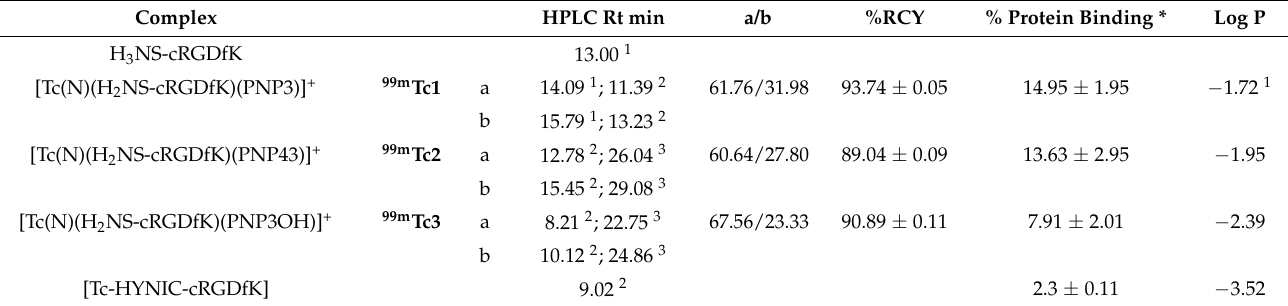
Table 1. RCY of 99m Tc1–3, along with their chromatographic